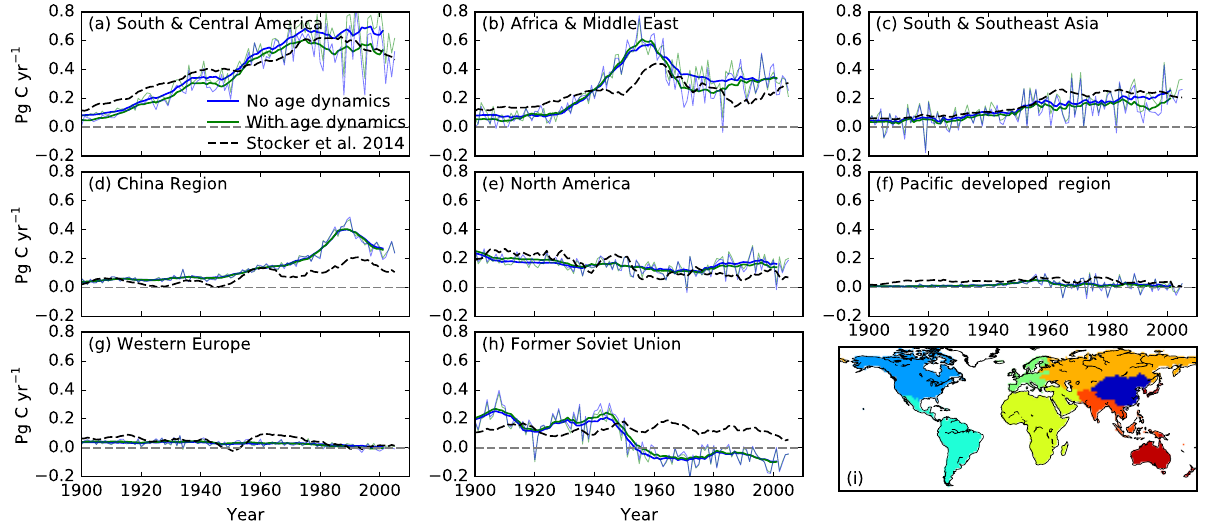
Figure 4. (a–h) Temporal patterns of regional land use change emissions in comparison with those from Stocker et al. (2014). Thicker solid lines indicate annual emissions smoothed using a 10-year moving average from our study, with blue (green) showing emissions from S ageless (S age ) simulations. Thinner solid lines indicate unsmoothed annual emissions from our study. Grey dashed lines indicate estimations from Stocker et al. (2014), smoothed using a 10-year moving average. Regional segregation of the globe is shown in (i)